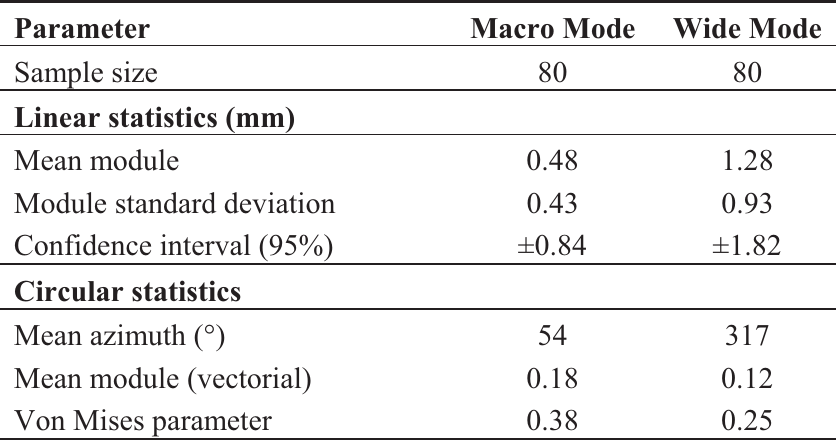
Table 2. Basic linear and circular statistics for the dispersion vectors of the B section corners.